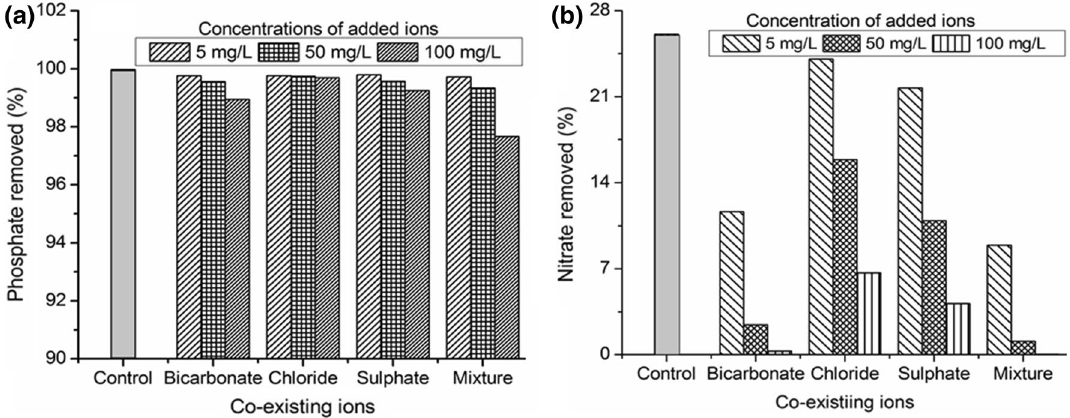
Fig. 6 Effect of coexisting ions on the simultaneous removal of a phosphate and b